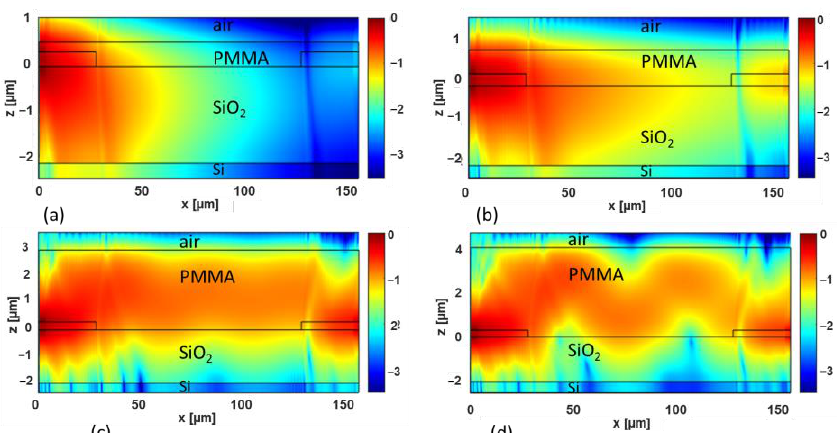
Figure 11. Normalized electric field (in logarithmic scale) calculated in the xz-vertical plane for y = 0 μm ( i.e., in the middle of the antennas), for the TM polarization. The link distance is d link = 100 μm , and different values of the thickness d are considered, namely: ( a ) d = 0.5 μm, ( b ) d = 0.9 μm, ( c ) d = 3 μm, and ( d ) d = 4 μm. The antennas and the multilayer interfaces are denoted by the black lines. The wavelength is λ = 1.55 µm.